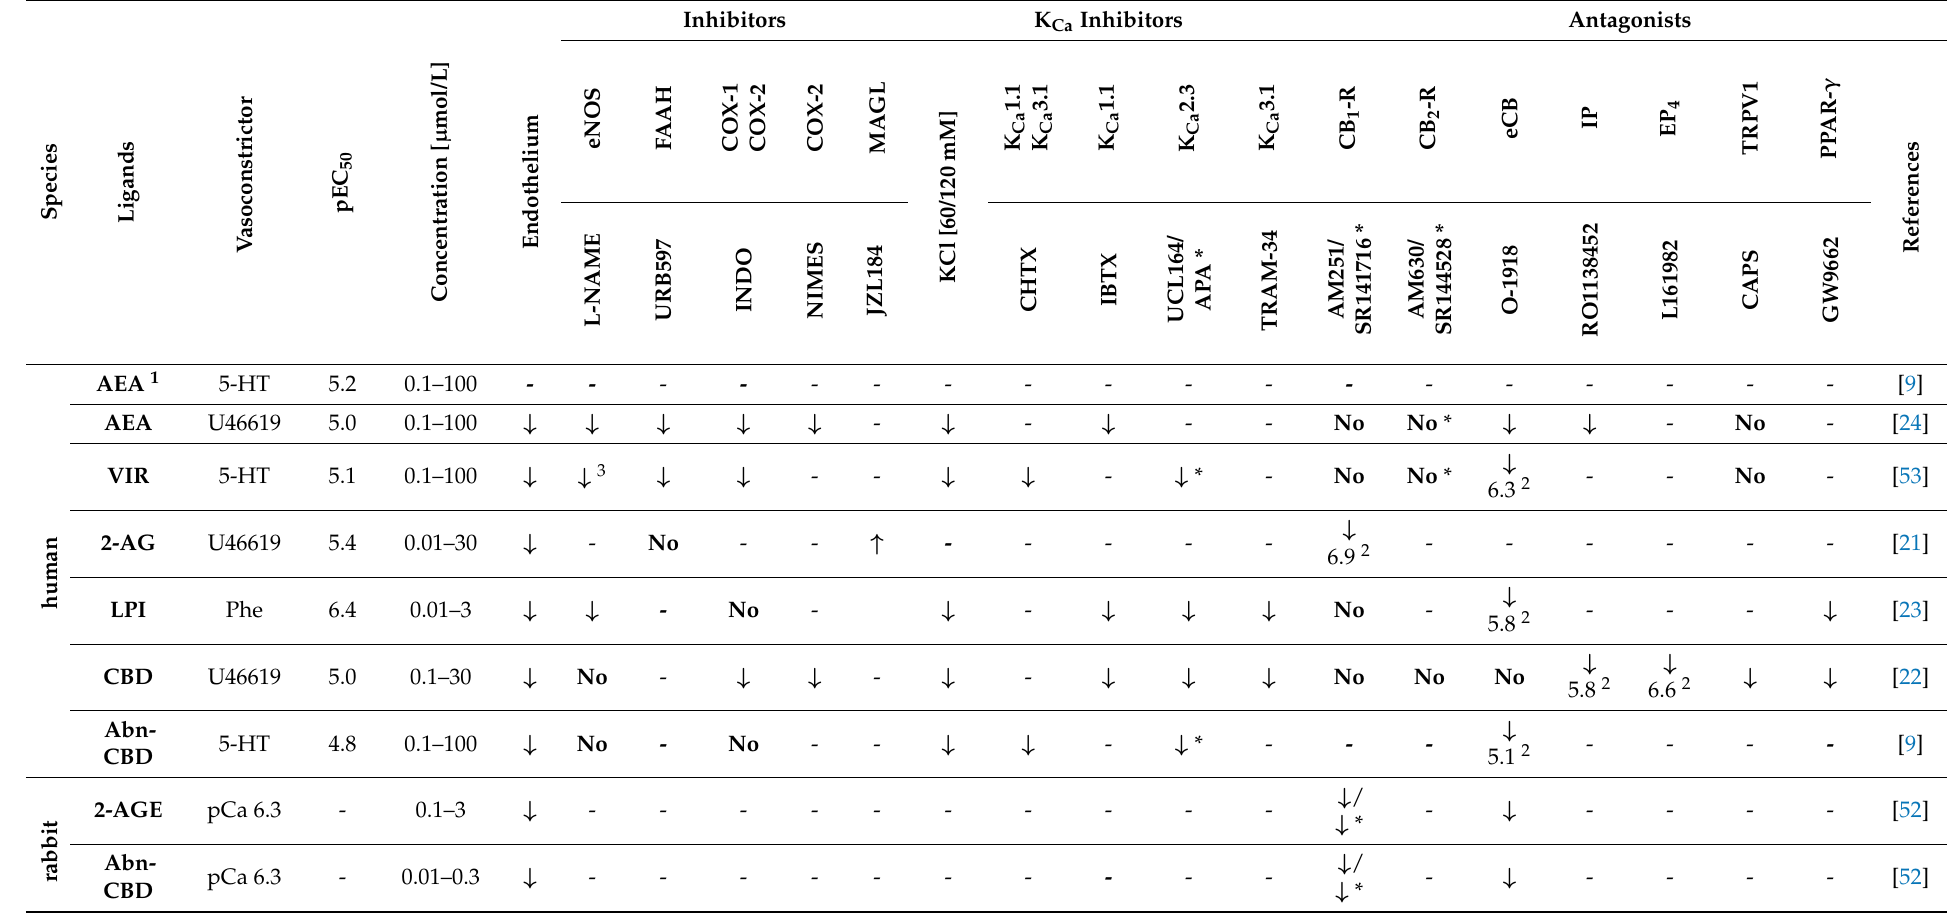
Table 3. The vasorelaxant effects of cannabinoids on the pulmonary